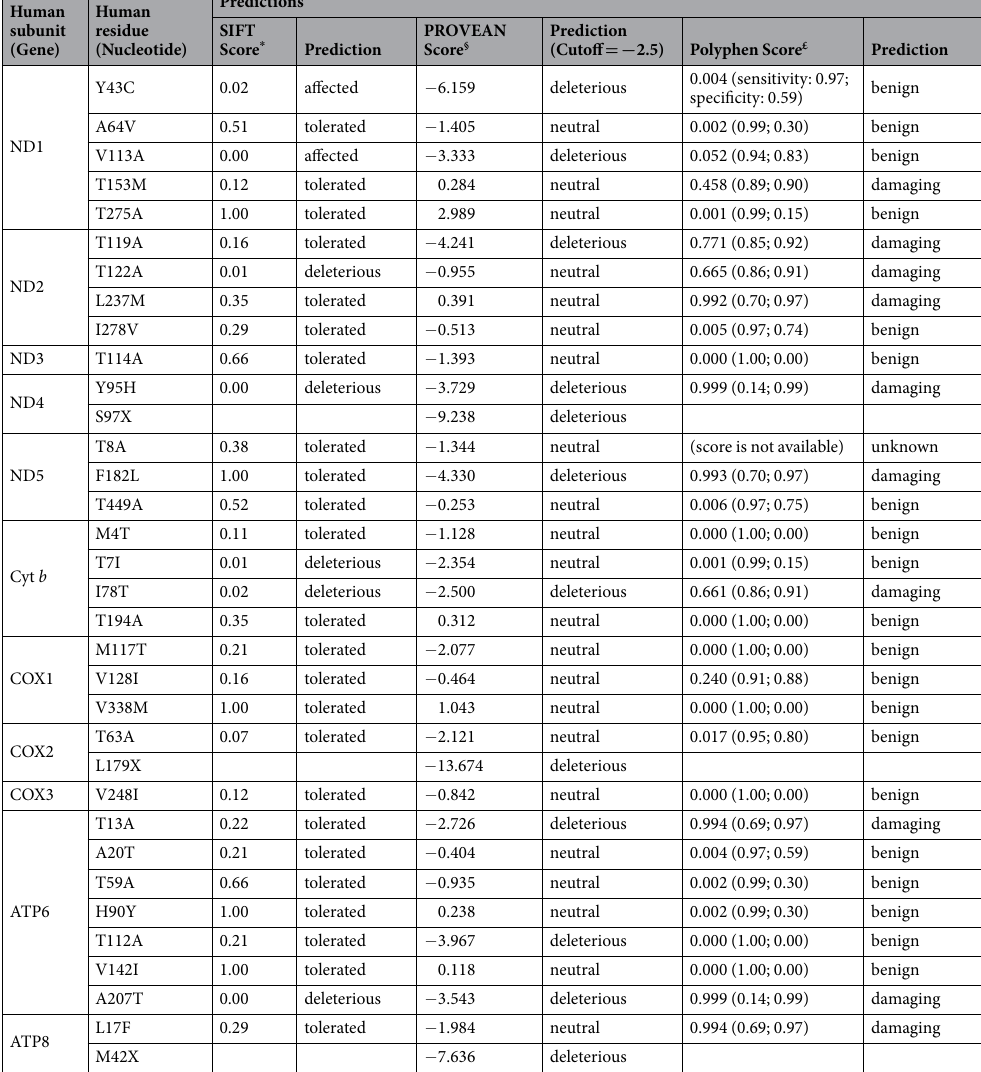
Table 5. Structural classification and pathogenic prediction of mutations in the mtDNA protein-coding genes. * Ranges from 0 to 1. The amino acid substitution is predicted damaging if the assigned SIFT score is <= 0.05, and the substitution is tolerated if the SIFT score is > 0.05. § Variants with a score equal to or below − 2.5 are considered “deleterious” and variants with a score above − 2.5 are considered “neutral”. £ The conservation of a position in the multi-sequence alignments and the deleterious effect on the protein structure results in the Position-Specific Independent Count (PSIC) score that ranges from 0 to 1. The classification of the nsSNPs results in Possibly Damaging and Probably Damaging (PSIC > 0.5) or Benign (PSIC < 0.5). mtDNA = mitochondrial